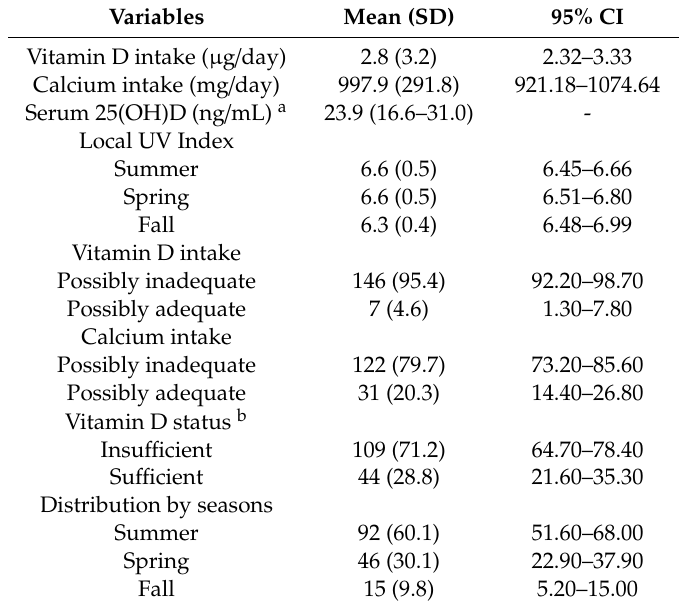
Table 2. Dietary and environmental characteristics of institutionalized elderly individuals ( n =